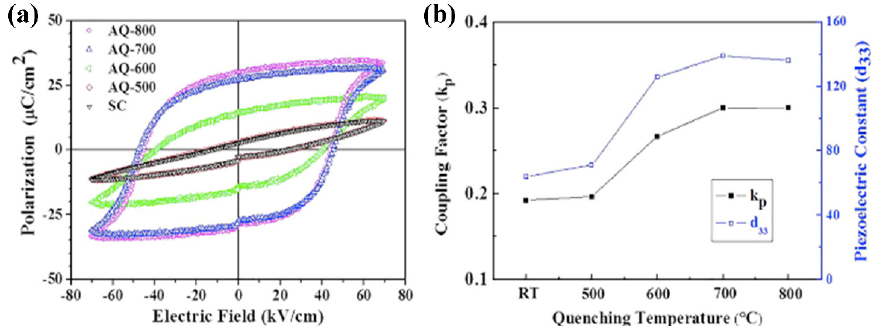
Figure 19. ( a ) P - E hysteresis loop and ( b ) d 33 and k p of 0.75BiFeO 3 –0.25BaTiO 3 ceramics as a function of quenching temperature. (SC: slowly cooled, AQ− x : air-quenching from x °C, x = 500, 600, 700, and 800). Reprinted with the permission of [101]. Copyright © 2016 AIP Publishing.